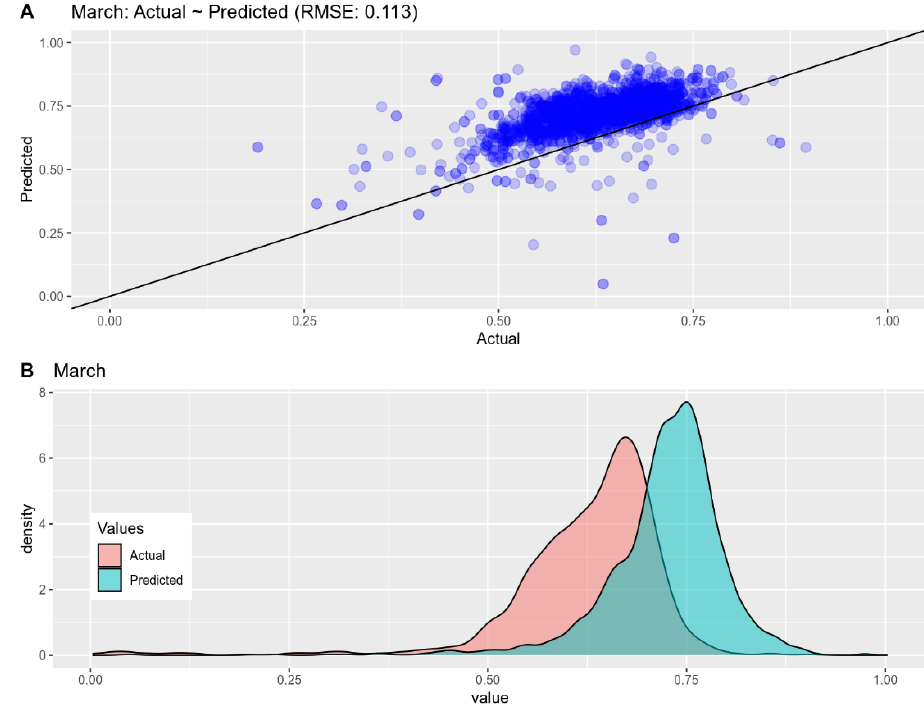
Figure A3. Comparison between actual~predicted for March 2020.